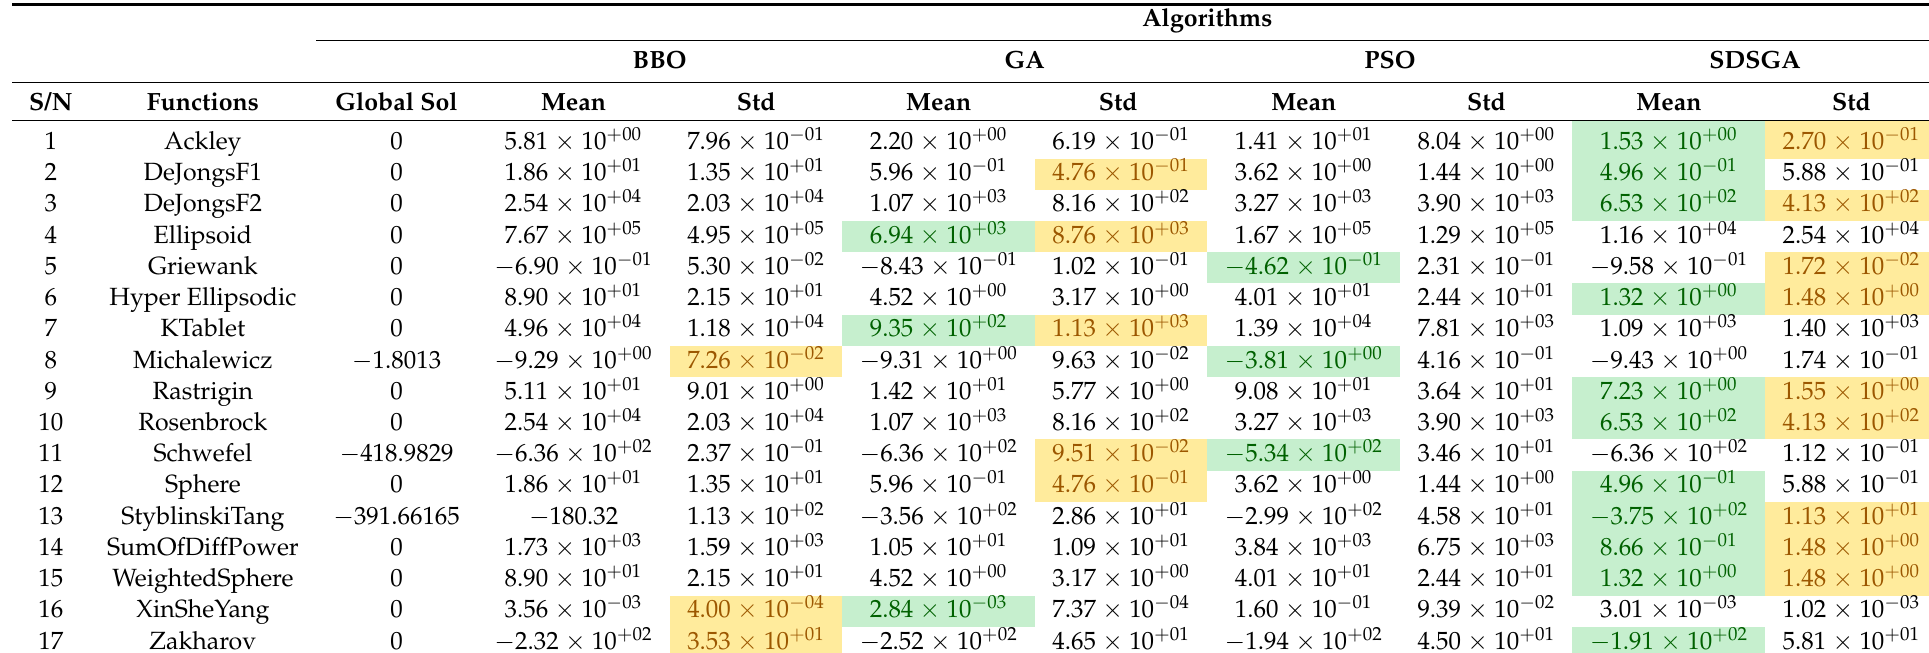
Table 2. Result of comparison of metaheuristic algorithms on benchmark functions in